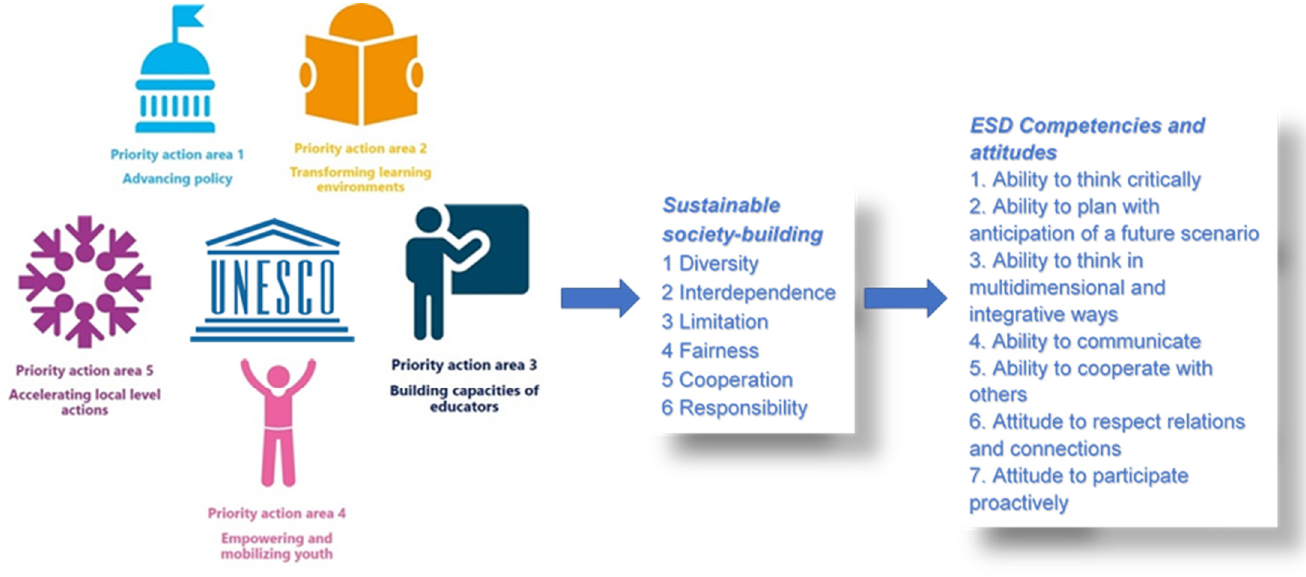
Figure 1. State of ESD in HEIs—general view. Source: Authors’ interpretation.